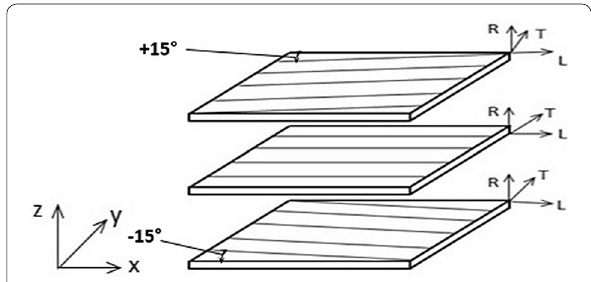
Fig. 4 Configuration of plywood specimen (plies arrangement -15°/0°/ 15°) +